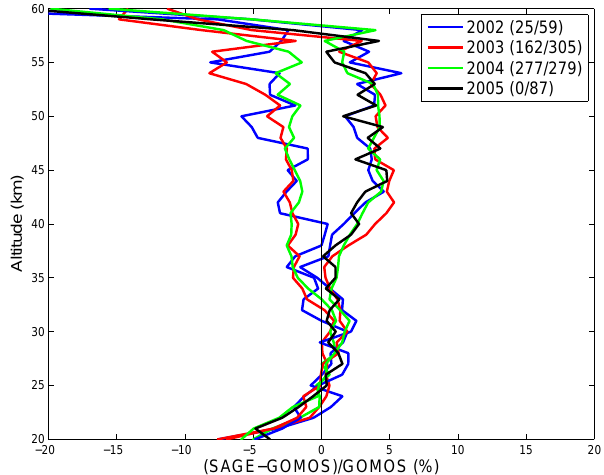
Fig. 9. The percent differences between SAGE II sunrise (mainly in left part of the figure) and sunset (mainly in right part of the fig- ure) measurements and GOMOS nighttime ozone measurements as a function of measurement year. The line labels show the centers of the latitude bands and the number of collocations